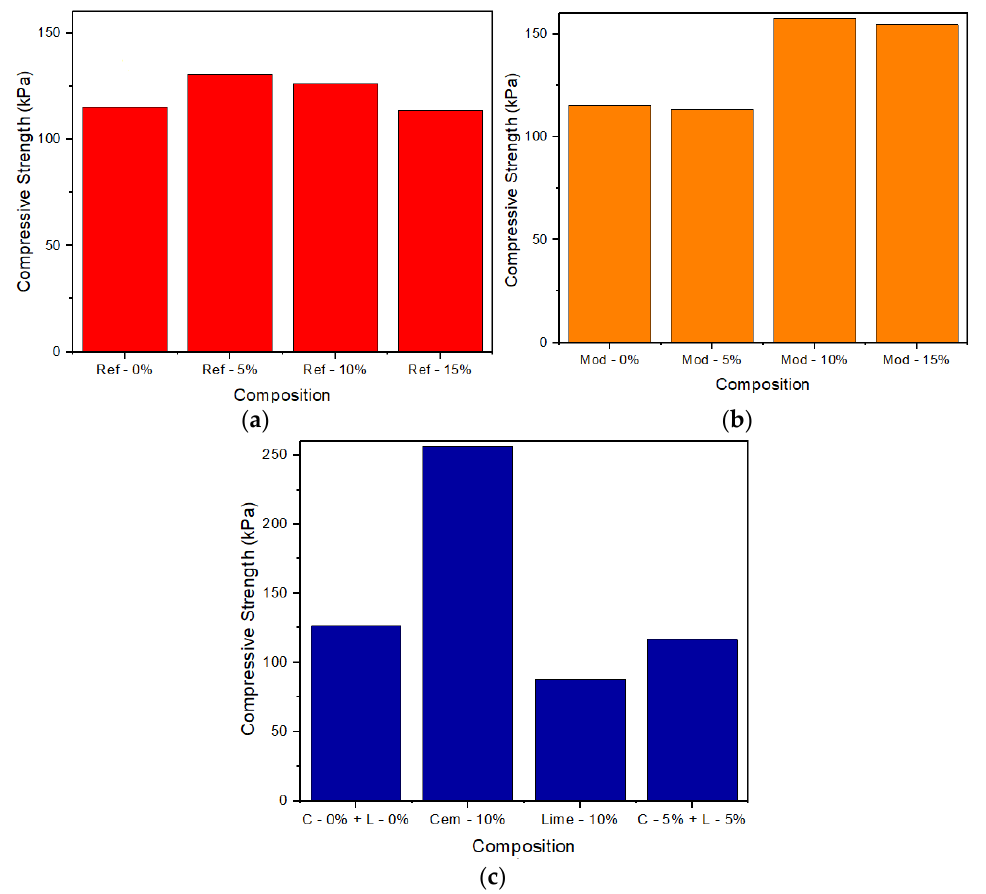
Figure 8. Compressive strength results: ( a ) adobe blocks with clay and manure (Ref-0%, 5%, 10% and 15%); ( b ) blocks containing sand (Mod-0%, 5%, 10% and 15%); ( c ) blocks containing cement and lime (C-0% + L-0%, Cem-10%, Lime-10%, and C-5% + L-5%).